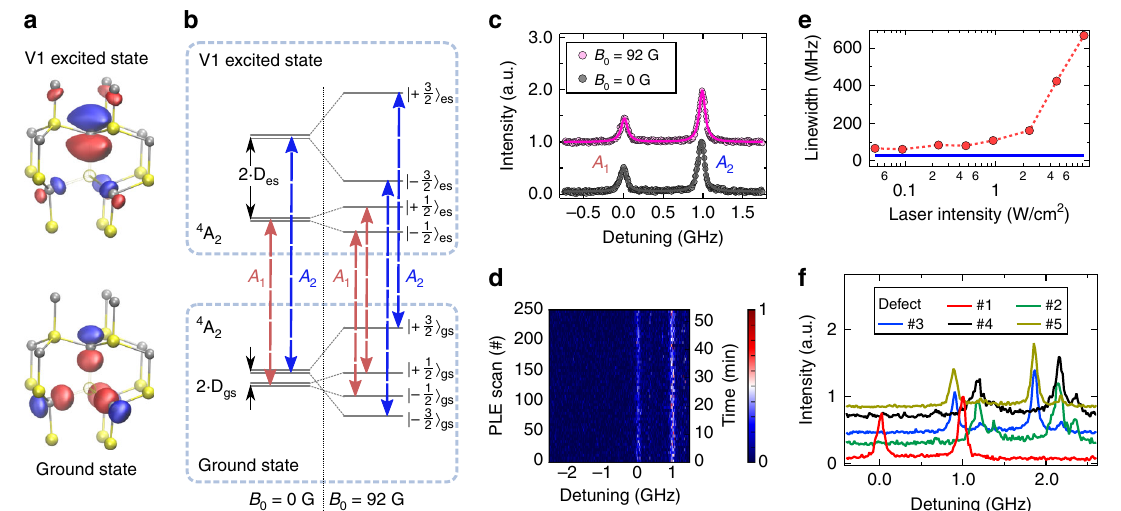
Fig. 1 Optical transitions of the silicon vacancy in 4H-SiC. a Crystalline structure of 4H-SiC with a silicon vacancy centre at a hexagonal lattice site. Upper (lower) fi gure shows the square moduli of the defect wave functions of the V1 excited (ground) state, as calculated by density functional theory. Red (blue) shaded areas symbolise that the wave function has a positive (negative) sign. The yellow and grey spheres represent silicon and carbon atoms, respectively, and the crystallographic c-axis is aligned vertically in this fi gure. b Ground and excited state level scheme with and without a magnetic fi eld applied along the c-axis. Red (blue) optical transitions labelled A 1 ( A 2 ) connect spin levels m S = ±1/2 ( m S = ±3/2). c Resonant absorption spectrum of a single vacancy centre at B 0 = 0 G and B 0 = 92 G. Lines are fi ts using a Lorentzian function. d Repetitive resonant absorption scans at B 0 = 92 G over 52 min without any sign of line wandering. The colour bar indicates the normalized intensity in arbitrary units. e Absorption linewidth of the peak A 2 as a function of the resonant pump laser intensity. Below 1 W/cm 2 no power broadening is observed and the linewidth is close to transform limited as indicated by the blue line. f Resonant absorption spectra of fi ve single defect centres, showing several defects with almost identical separation between two ZPLs and linewidth but inhomogeneously